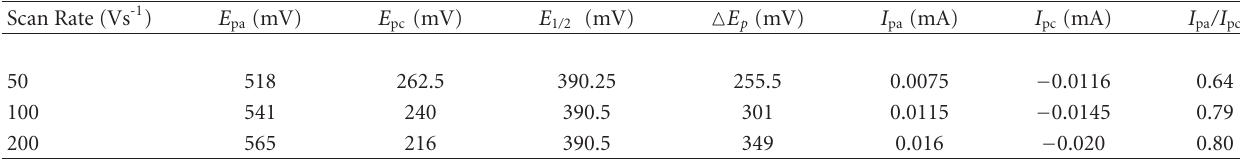
Table 2: Redox properties of complex in [Cu( bemims )(NO 3 ) 2 ] CH 3 CN at 25 ◦ C. Scan rate 50–200 mVs − 1 , E vs Ag/AgCl.